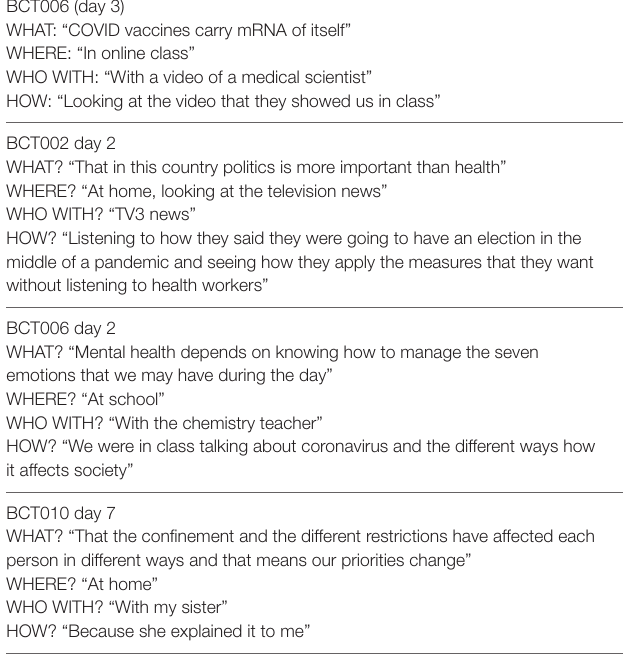
TABLE 5 | Meaningful learning experiences associated with COVID-19. BCT006 (day 3) WHAT: “COVID vaccines carry mRNA of itself” WHERE: “In online class” WHO WITH: “With a video of a medical scientist” HOW: “Looking at the video that they showed us in class”